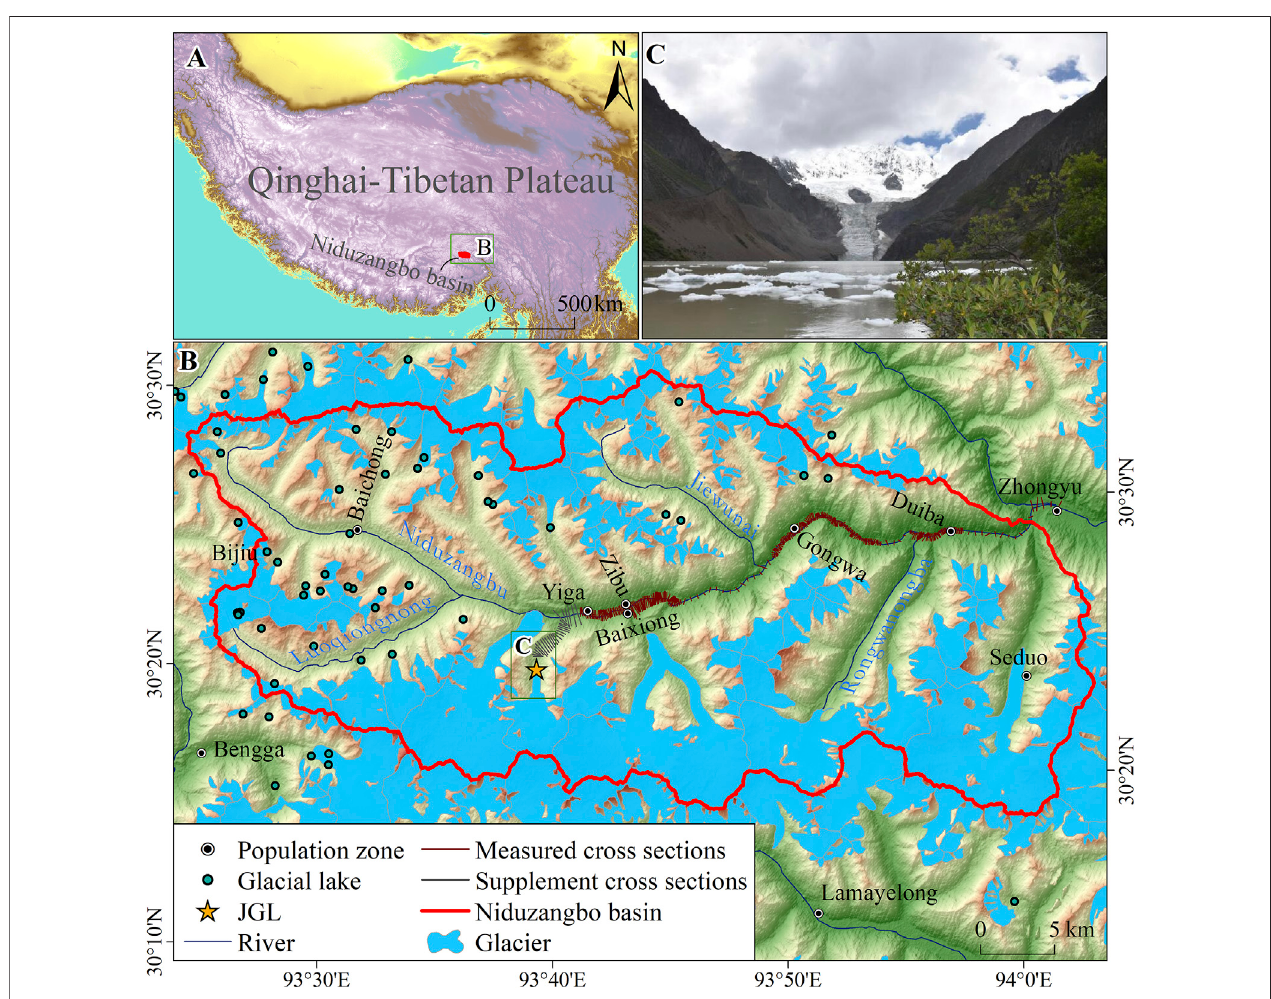
FIGURE1| Locationofthestudyarea. (A) isthelocationoftheNiduzangbobasinintheQinghai-TibetanPlateau. (B) isthegeographicalsettingoftheNiduzangbo basin and locations of measured and supplement cross sections. (C) is the photo of JGL taken by Yao in 2017.